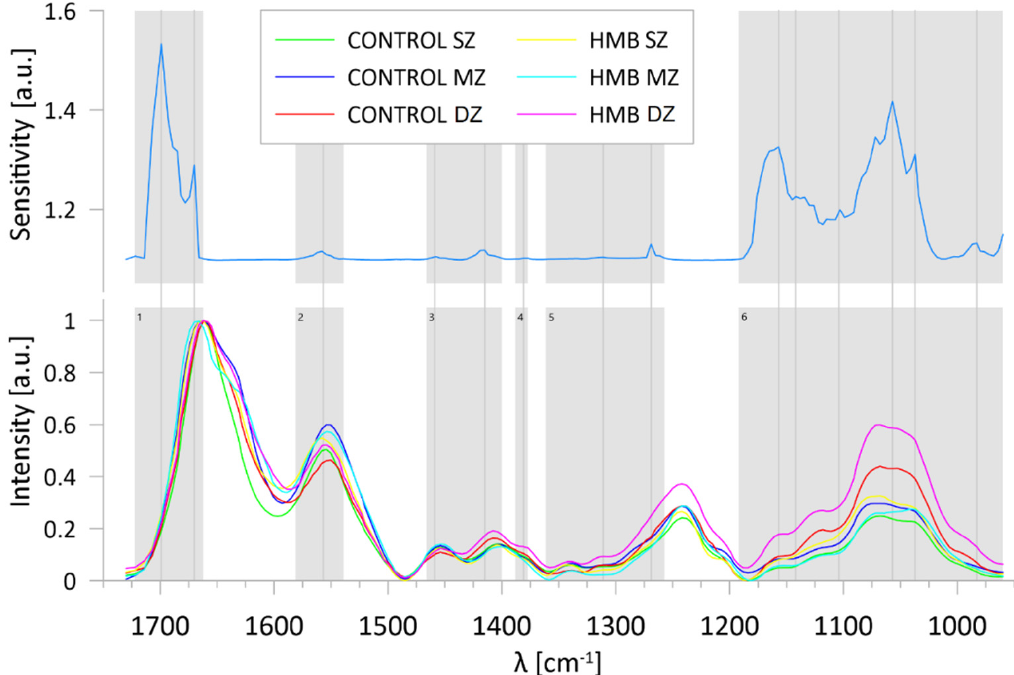
Figure 7. Wavenumber ranges indicated by the ANNs sensitivity analysis with marked peaks in each (grey, vertical lines) and corresponding spectra averaged for each group: (range 1) 1722-1667 cm − 1 ; (range 2) 15981-1539 cm − 1 ; (range 3) 1466-1400 cm − 1 ; (range 4) 1385-1377 cm − 1 ; (range 5) 1361-1257 cm − 1 ; (range 6) 1192-960 cm − 1 ; HMB—supplemented group, SZ—superficial zone, MZ—middle zone, DZ—deep zone.